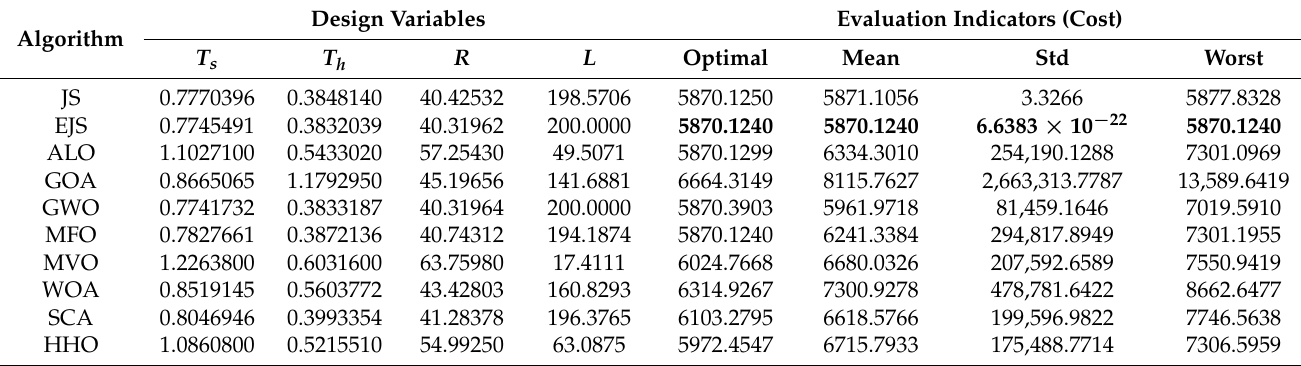
Table 7. Evaluation indicators and variable values for Figure